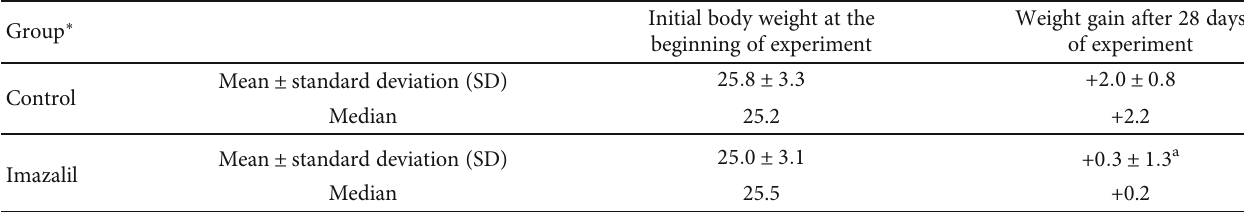
Table 3: Body weight and weight gain in Swiss albino mice after 28 days of treatment with imazalil expressed as mean standard deviation (SD) and